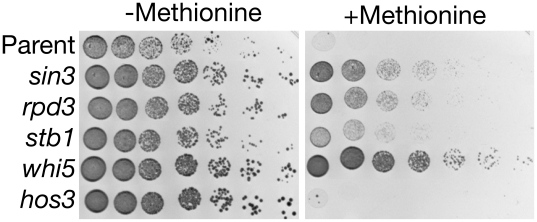
Suppressors of cln3 bck2.Various mutations were tested for ability to suppress lethality of a cln3 bck2 rme1 {MET-CLN2} strain on +methionine medium. The parental strain (N497) is cln3 bck2 rme1 {MET-CLN2}; other strains (top to bottom: N452, N453, N451, N499, and N454) have one additional mutation as indicated. Serial 4-fold dilutions were spread on −methionine (where MET-CLN2 is expressed) or +methionine (where MET-CLN2 is repressed). The HOS3 gene encodes a histone deacetylase, but this histone deacetylase was not identified in our suppressor screen and serves as a negative control.